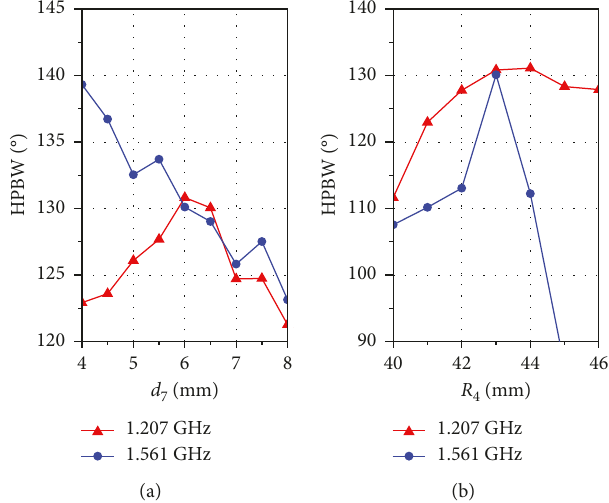
Figure 12: Effects of (a) the gap between the two APMSs and (b) the R-GP on the